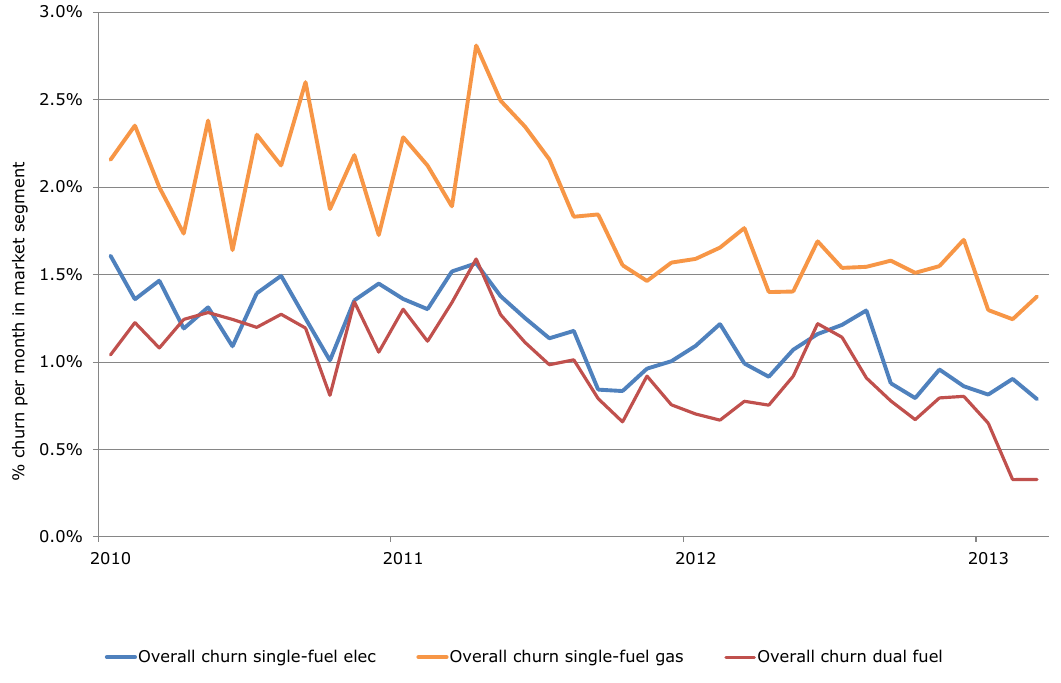
Figure 25: Overall switching rates in single-fuel electricity, single-fuel gas and dual